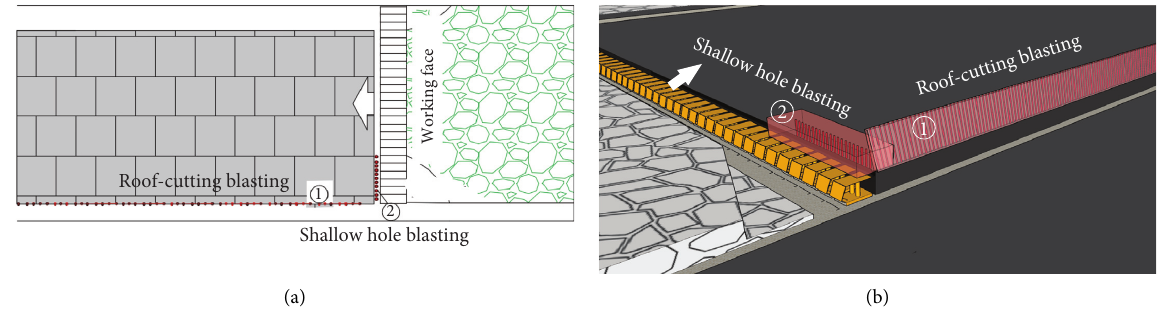
Figure 3: (a) Plan view of the integrated presplitting blasting technology design. The shallow hole blasting before the working face support is to fragmented regional roof, and the roof-cutting blasting on the side of the road is to cut off the roof of the roadway and goaf. (b) Three- dimensional view of the integrated presplitting blasting technology design, which allows for a more intuitive display of design